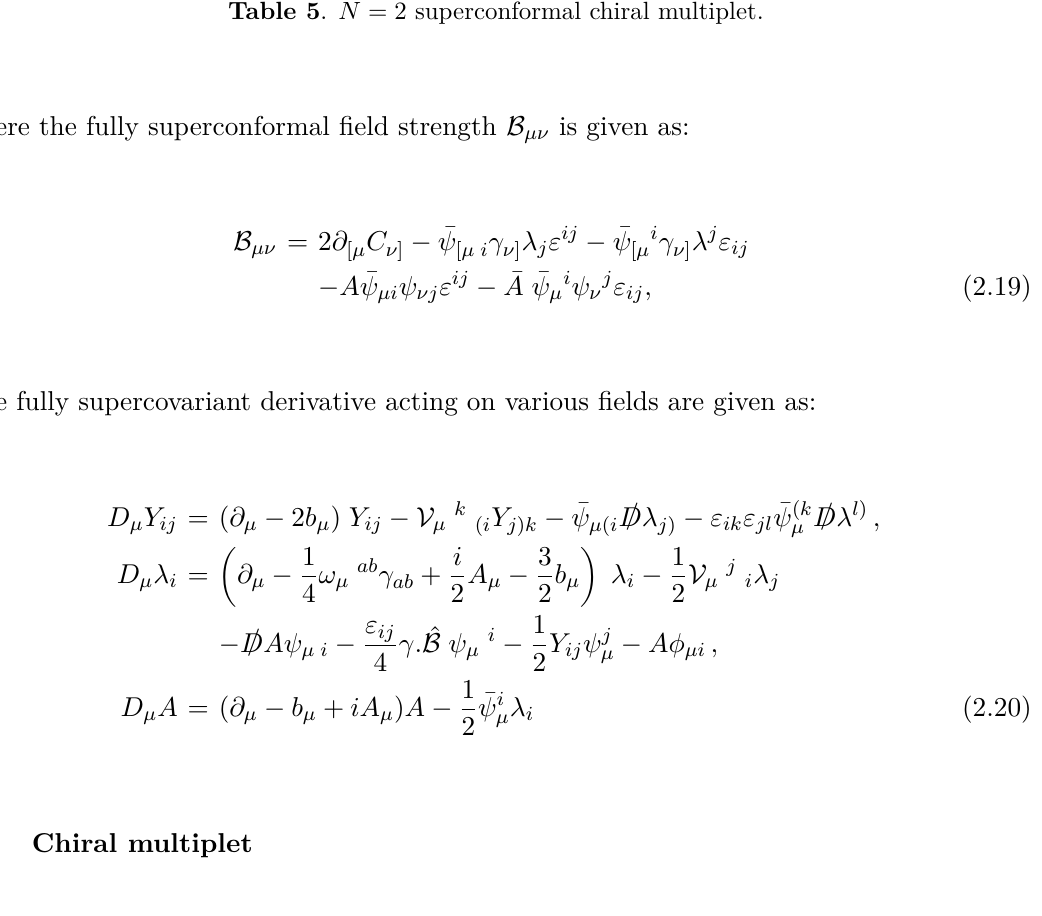
Table 5 . N = 2 superconformal chiral